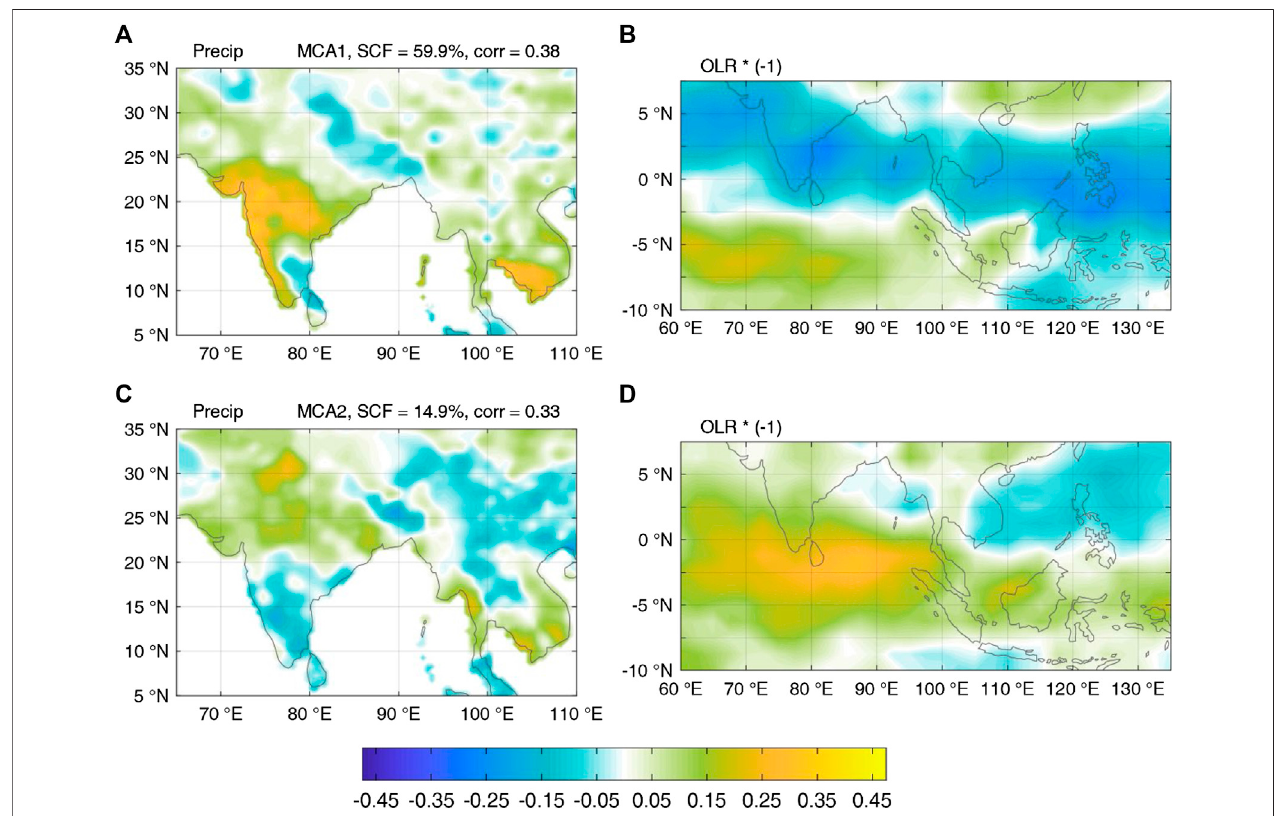
FIGURE3| Heterogeneouscorrelation maps ofthe fi rst (A, B) andsecond (C,D) MCAmodes betweendailyprecipitation (A, C) and OLR (B,D) anomaliesduring 1986 – 2010 JJA, with the OLR leading by 20 days. Areas for MCA are 70 ° – 90 ° E, 10 ° – 30 ° N (precipitation) and 60 ° – 135 ° E, − 10 ° to 7.5 ° N (OLR). The square covariance fractions explained by each mode is 59.9% and 14.9%, respectively. The correlation coef fi cient between the MCA time-series is 0.38 and 0.33 for each mode, respectively. Both modes passed the signi fi cance test at the 95% level using a Monte Carlo approach. The signs in the OLR maps are reversed so that positive (negative)anomaliescorrespondtoenhanced (suppressed)tropical convections.BothprecipitationandOLRanomaliesarepreprocessedbya10-daymovingaverage.